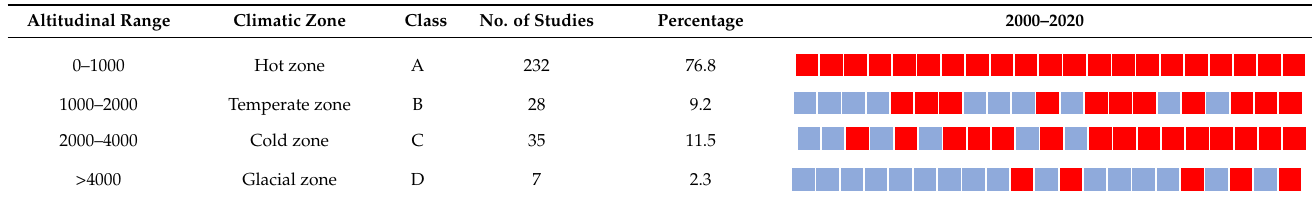
Table 3. LAC’s flood-related articles ranked according to the altitudinal range of the study area and its growth.